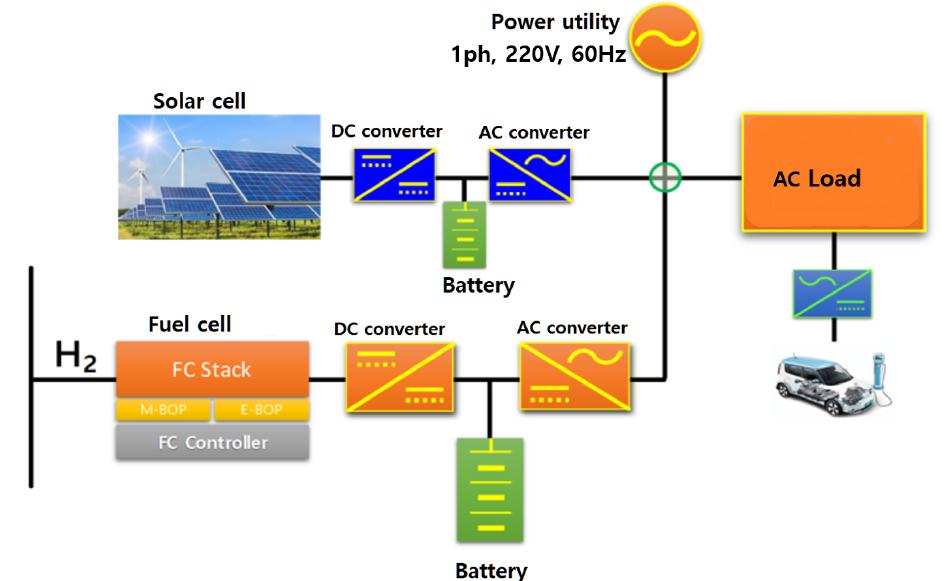
Figure 1. Structure of the hybrid energy storage system of solar, fuel power battery, and power utility under the load.